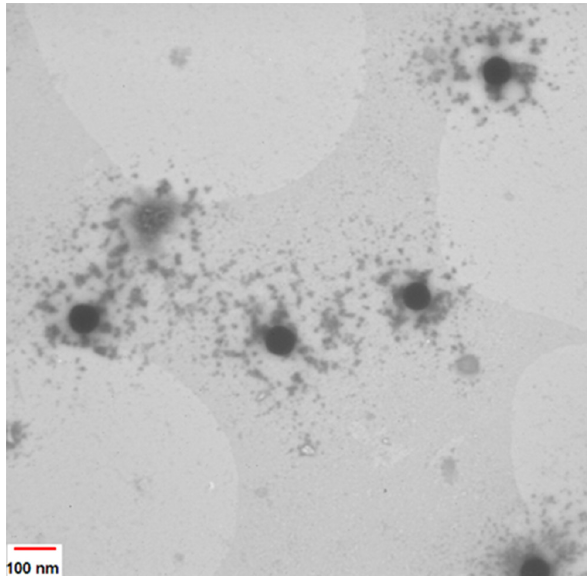
Figure 8: Size distribution of the synthesized Se NPs.